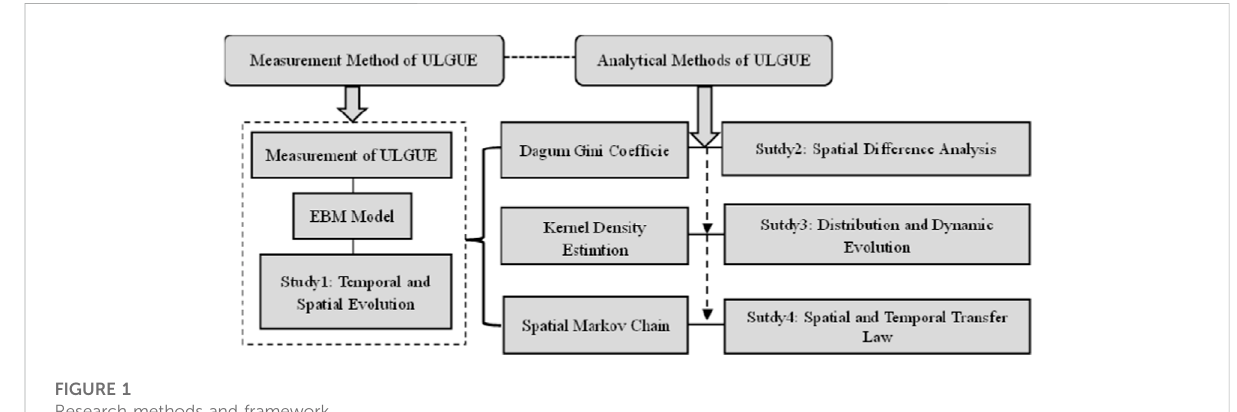
FIGURE 1 Research methods and